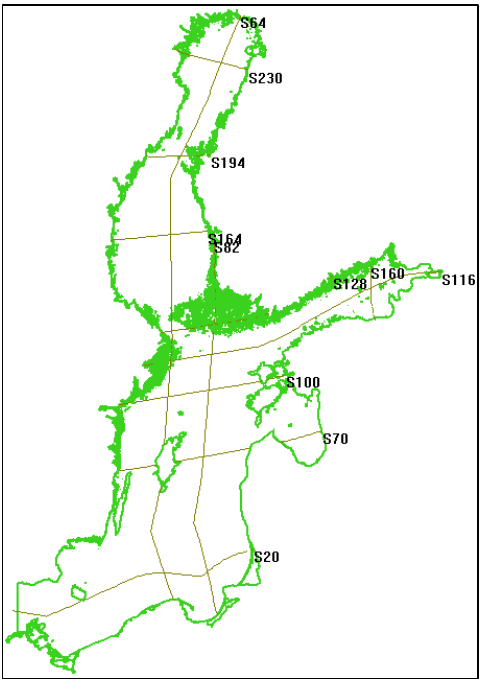
Figure 10. Selected cross sections in the Baltic Sea for vertical structure analysis.